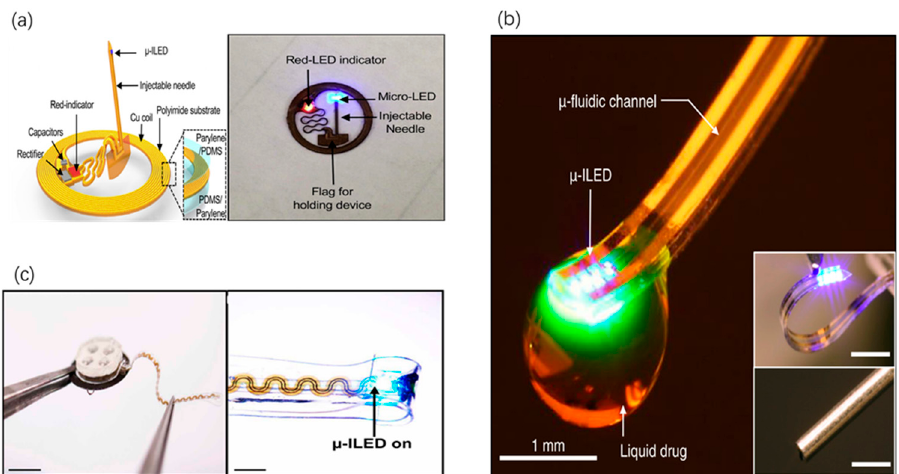
Figure 6. Integrated implantable active optical devices. ( a ) Left: Schematic illustration of the overall construction, highlighting a freely adjustable needle with a m-ILED at the tip end, connected to a receiver coil with matching capacitors, a rectifier, and a separate m-ILED indicator. (Inset) Magnified view of the channels. Scale bar, 100 mm. Right: Representative image of implantable device. Reprinted with permission from [64]. Copyright 2016, Elsevier Inc. ( b ) Optofluidic neural probe during simultaneous drug delivery and photostimulation. (Insets) Comparison of such a device (top) and a conventional metal cannula (bottom; outer and inner diameters of 500 and 260 mm, respectively). Scale bars, 1 mm. Reprinted with permission from [65]. Copyright 2015, Elsevier Inc. ( c ) Left: Demonstrations of the overall size of the system. Scale bars, 5 mm. Right: Magnified views of the neural cuff interface with optical μ -ILED activation. Reprinted with permission from [66]. Copyright 2019, American Association for the Advancement of Science (AAAS). Table 3. Optical modules and fabrication process of integrated implantable optical devices.